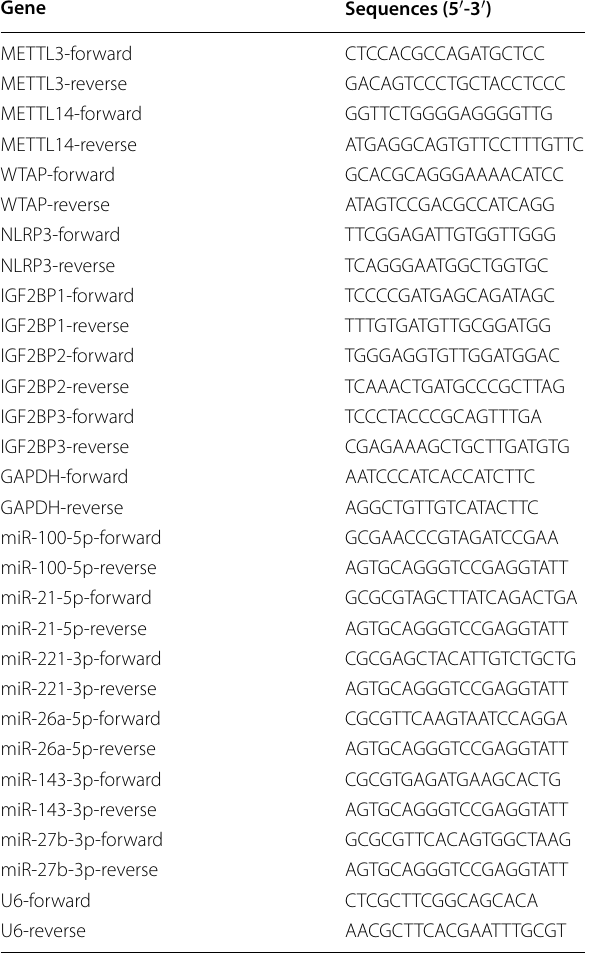
Table 2 Primes sequences used in this study Gene Sequences (5 ′ -3 ′